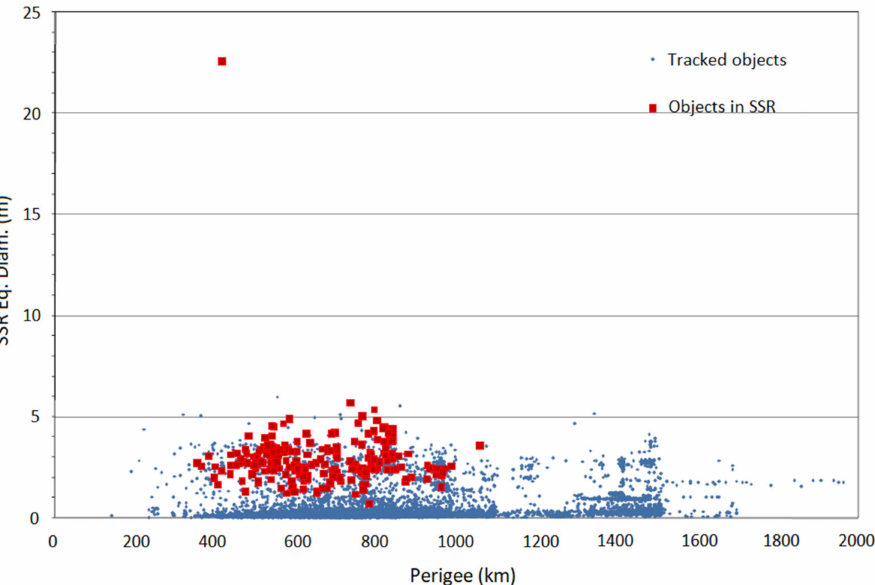
Figure 22. Object diameter vs. perigee for post march 2015 Antenna Bistatic for Space Surveillance (ABISS) debris measurements [53]. © 2012 IEEE. Reprinted with permission from Saillant, S. Exo- Mars spacecraft detection with European Space Surveillance bistatic radar. 2016 CIE International Conference on Radar, Guangzhou, China, 10–13 October